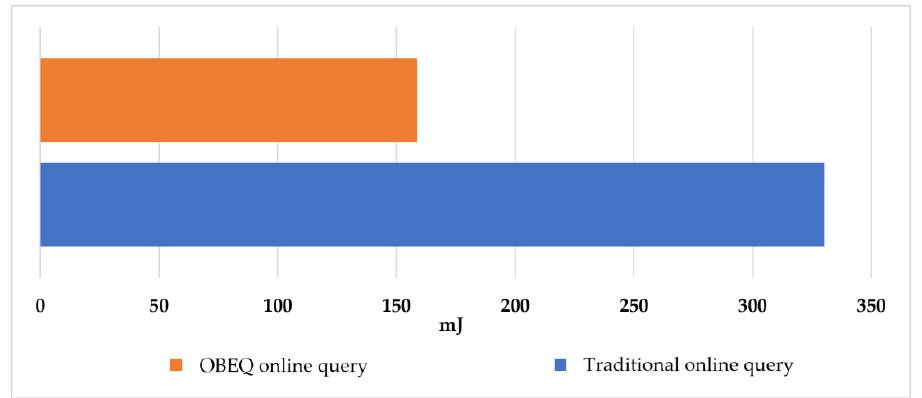
Figure 15. The power consumption of MAX aggregation.